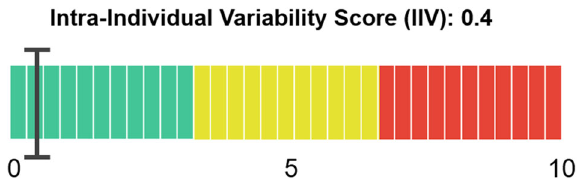
Fig. 7 The IIV quanti fi es the variability of cognitive domain percentiles over time. The value corresponds to the average variability of the subject ’ s test in multiples of the variability of healthy subjects for each domain. The value is only reliable for at least fi ve tests done by the same